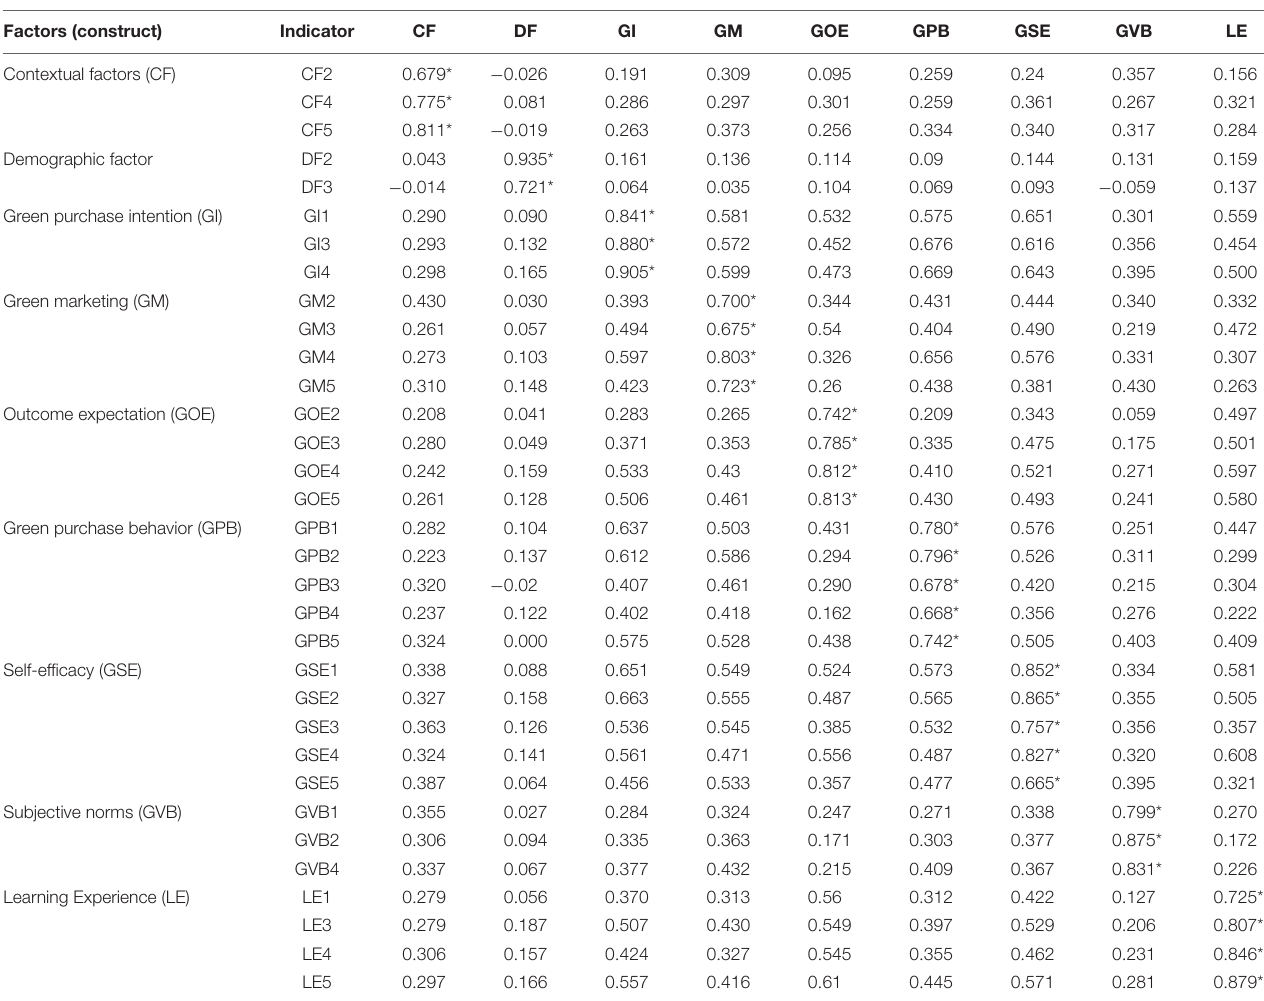
TABLE 4 | The result of discriminant